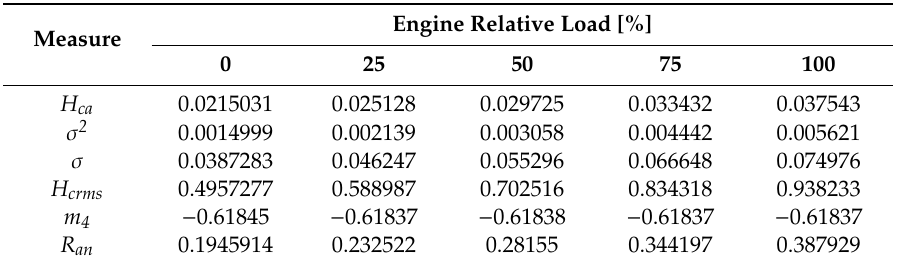
Table 1. The values of statistical measures of the pressure spectral symptoms in the engine cylinder for individual relative loads of the internal combustion engine: Hsa —average value of amplitude harmonic in spectrum, σ 2 —variance, σ —standard deviation, m 2 —the second degree central moment, H crms —root-mean-square value of amplitude harmonic in spectrum, R an